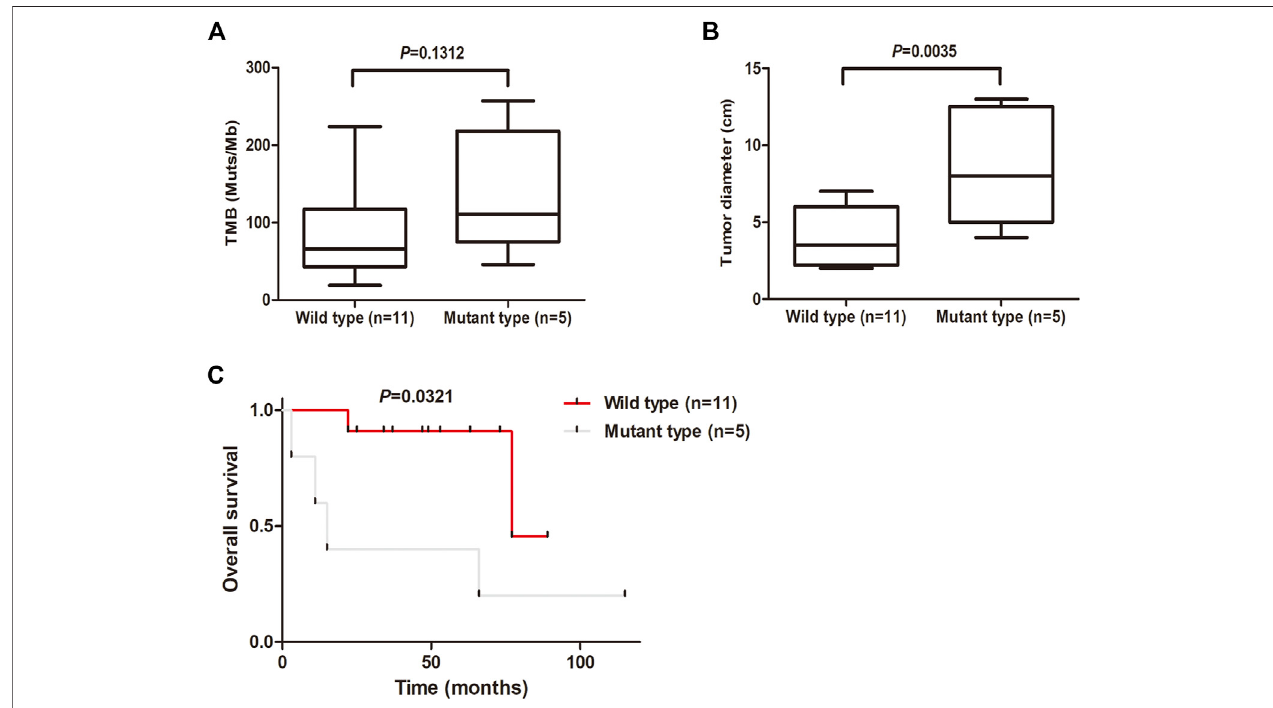
FIGURE 4 | KMT2D mutations are associated with large tumor size and unfavorable prognosis. (A) Comparison of TMB (mutations/MB) between the KMT2D wild-type group and mutant-type group. (B) Comparison of tumor diameter between the KMT2D wild-type group and mutant-type group. (C) Survival analysis for patients between the KMT2D wild-type group and mutant-type